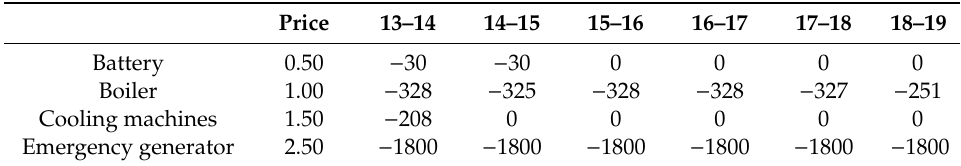
Table 9. Bids for iteration